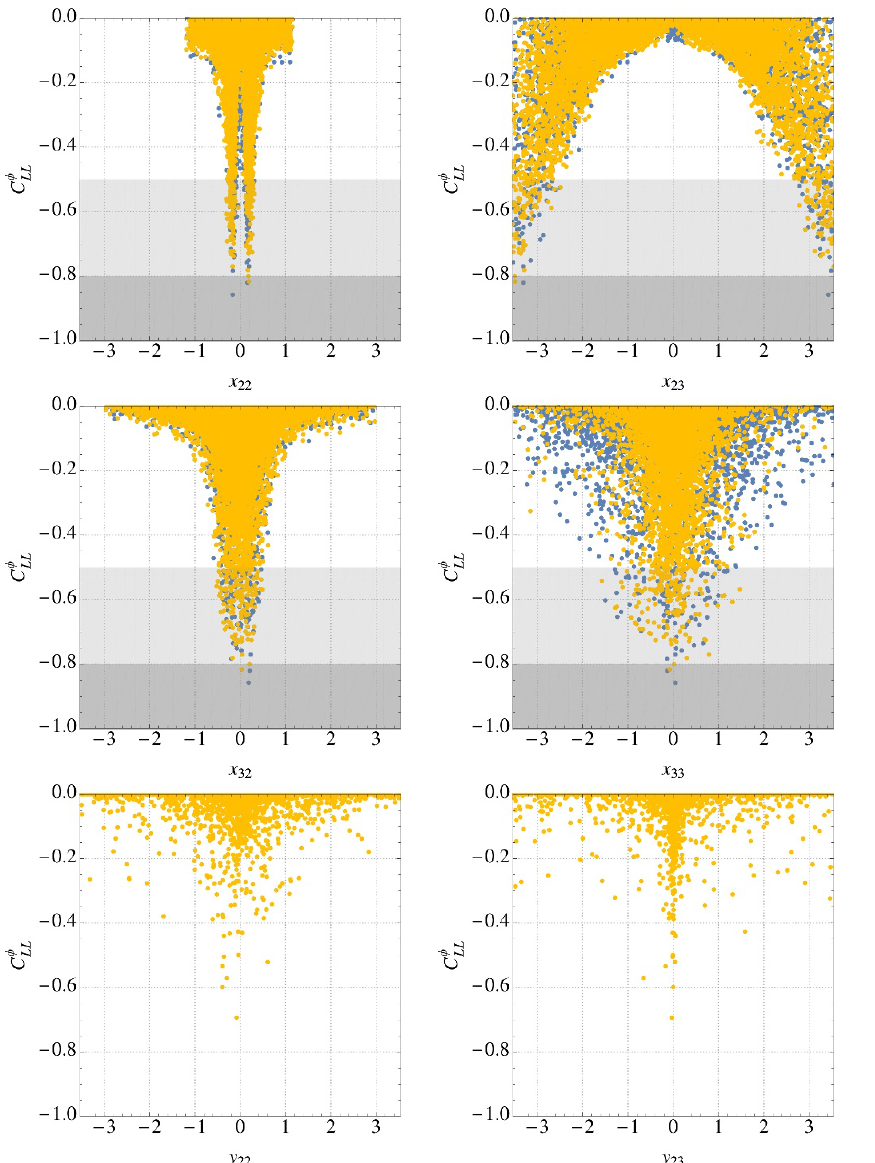
Figure 10. Slices through the parameter space investigated through scans I and II. The value of is plotted against each Yukawa coupling scanned over. Plots agains the x contain points from C (cid:30) ij LL scan II and hence 1 and 2 (cid:27) regions for R can be speci(cid:12)ed since C = 0, these are shaded grey, LR K ( (cid:3) ) and points implying SM-like R values are shown in yellow. Plots against the y 2 are from scan i D ( (cid:3) ) I, for which all points predict SM-like R since y 32 = 0. Large values of x 23 are essential for an D ( (cid:3) ) adequate explanation of the b ! s data in this model, while small, but non-zero, values for x 22 are necessary to allow C (cid:30) to be negative. The values of x 23 required to explain the LFU observables p LL to 2 (cid:27) begin to impinge on the perturbativity constraint j x 23 j < 4 (cid:25) .